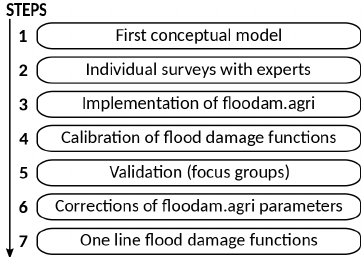
Figure 1. Development process of the national flood damage func- tions for